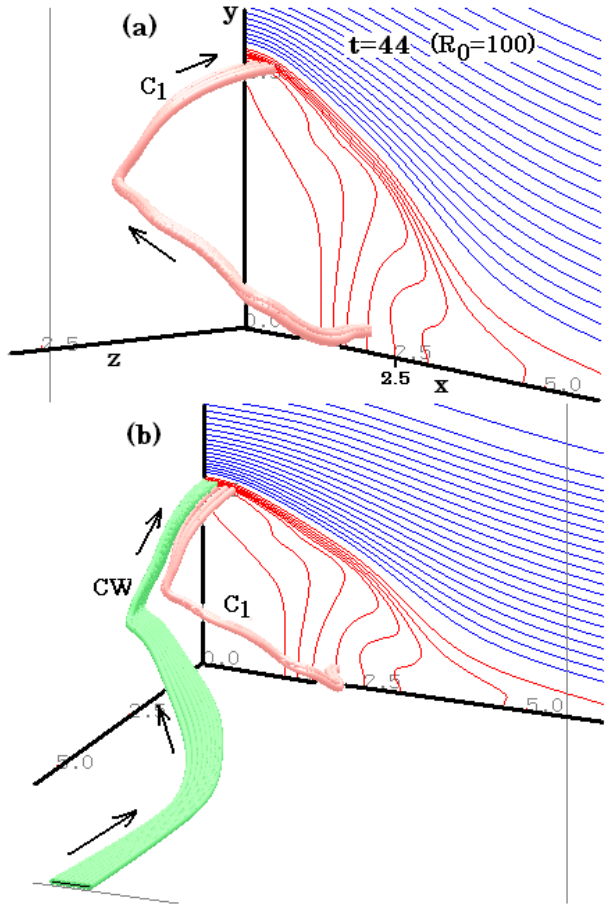
Fig. 11. (a) Current flow lines, denoted by C 1 , that pass through the generator region ahead of the loop top, and in (b) the current wedge (CW) that is formed simultaneously is also